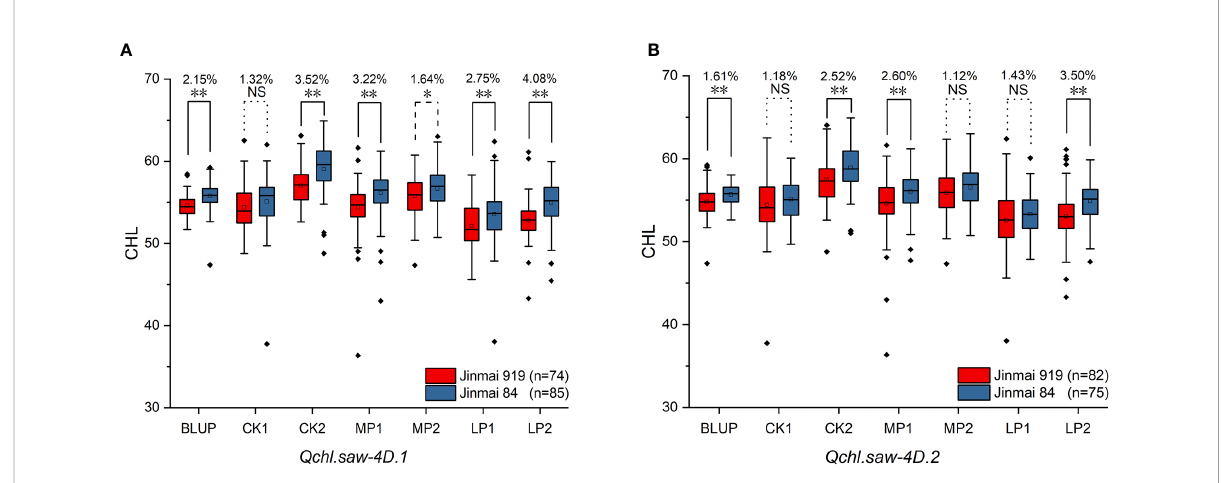
FIGURE 4 Validation of Qchl.saw-4D.1 (A) , and Qchl.saw-4D.2 (B) in DH2 (Jinmai 919 × Jinmai 84) population under different environments. ** Signi fi cant at P <0.01; * Signi fi cant at P <0.05; NS, not signi fi